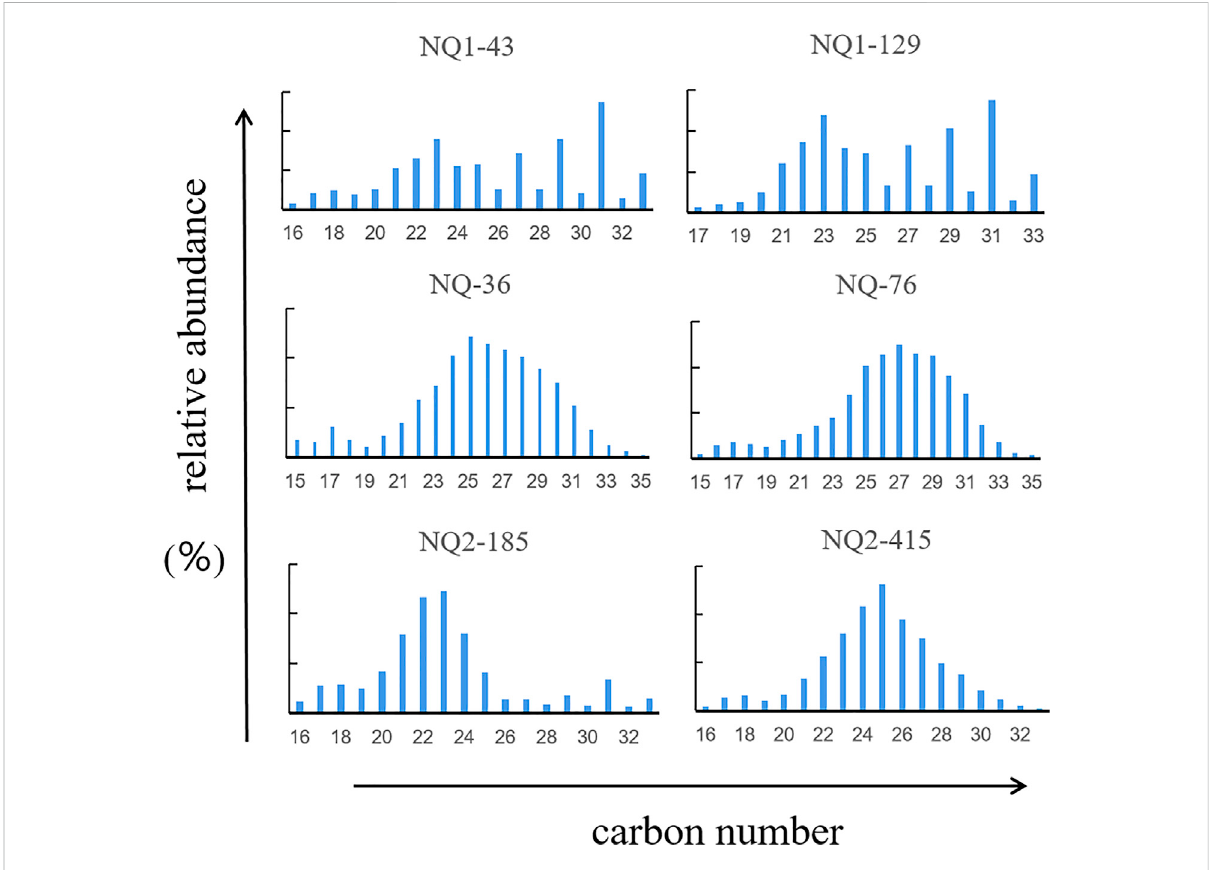
FIGURE 3 Distribution map of n -alkanes in Nangqian